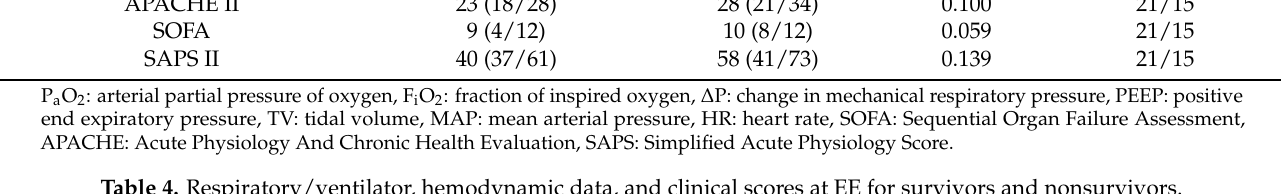
Table 4. Respiratory/ventilator, hemodynamic data, and clinical scores at EE for survivors and nonsurvivors.